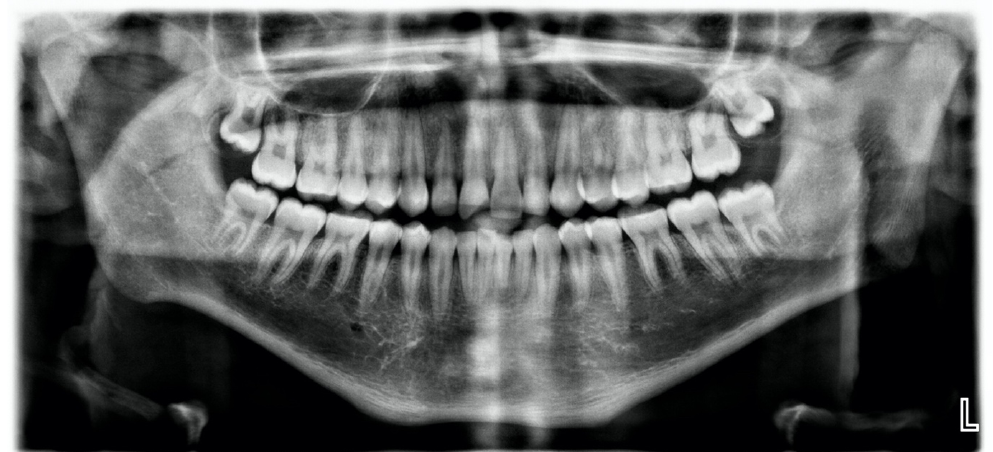
Figure 2. The ASD patient’s orthopantomogram shows a dentition free of caries and restorations, and the diagonally fractured incisal edge of tooth 11. No apical translucency or widened periodontal gap is visible. ( © Witten / Herdecke